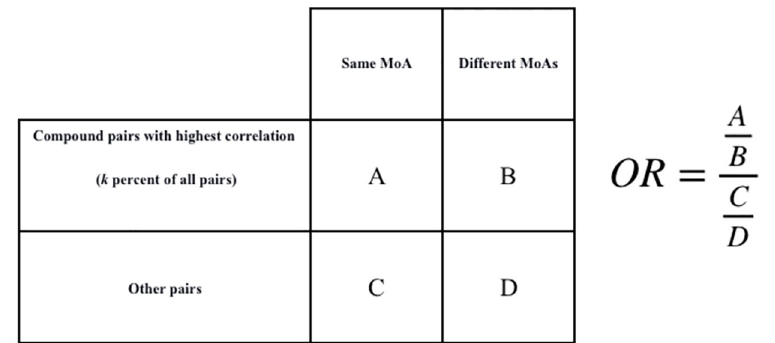
Fig 9. Odds ratio. Calculation of odds ratio.